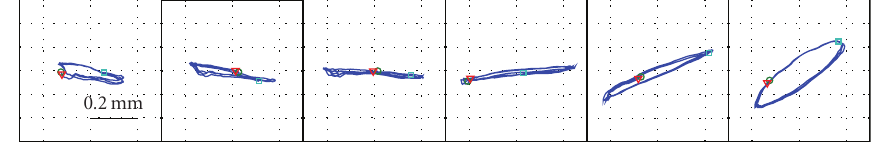
Figure 13: Orbits on the intershaft (measurement station 7) around the first backward whirl